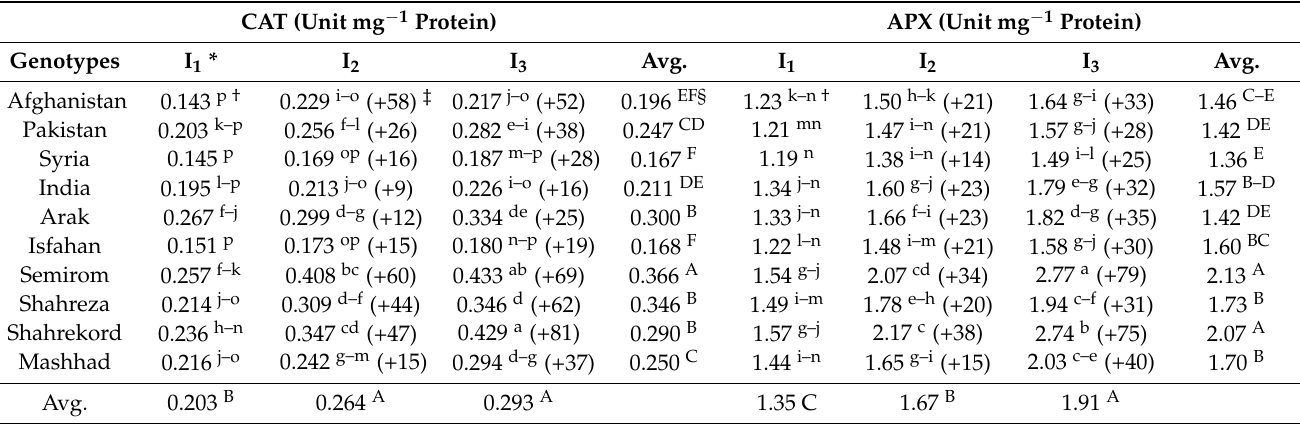
Table 6. Mean comparison of the effect of irrigation regime (I), genotype (G), and their interaction on CAT and APX of black cumin.